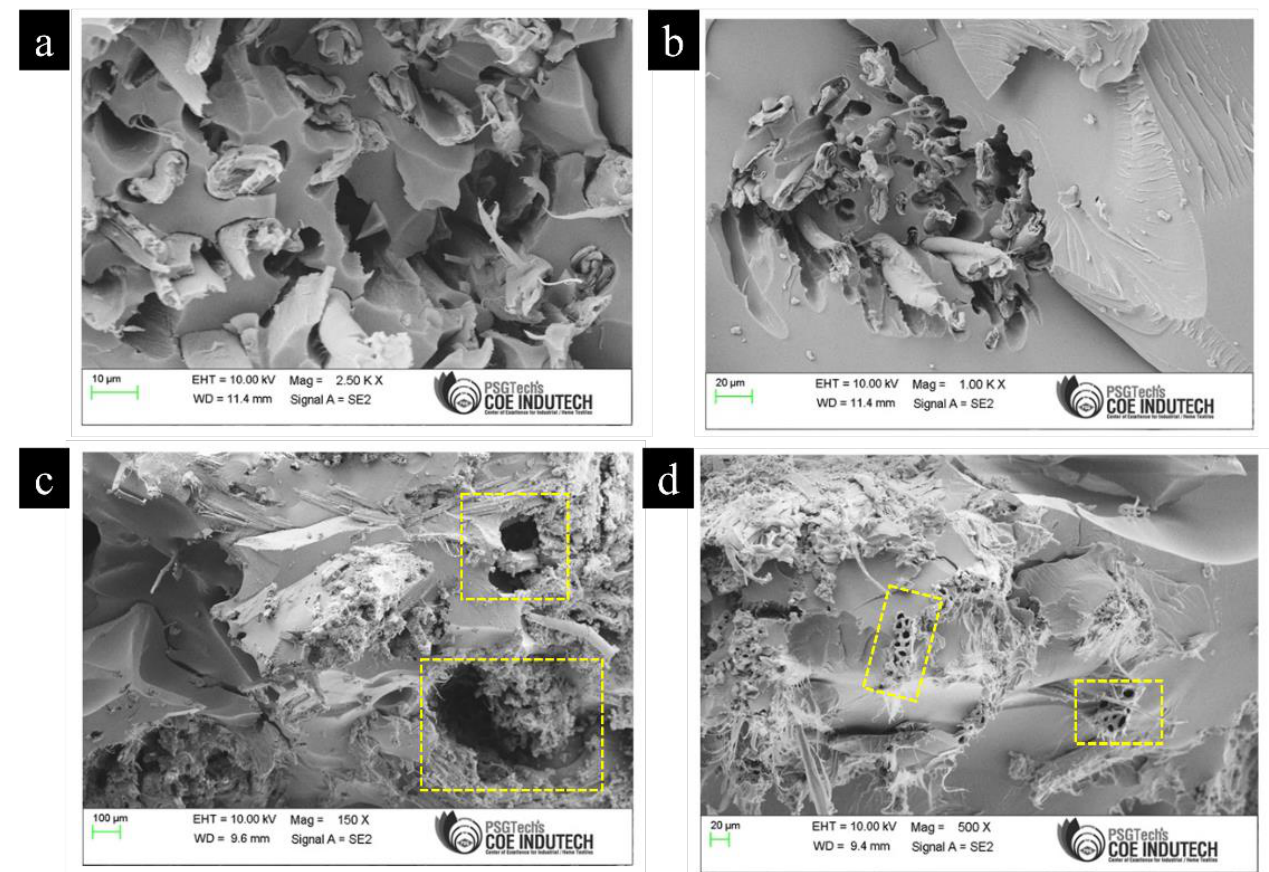
Figure 9. SEM images of samples subjected to flexural testing ( a,b ) laminate 3 (Bamboo + Kenaf + Epoxy) ( c,d ) laminate 6 (Kenaf + Bamboo + Epoxy + Table 5. Summary of mechanical properties of composites fabricated in the present study.